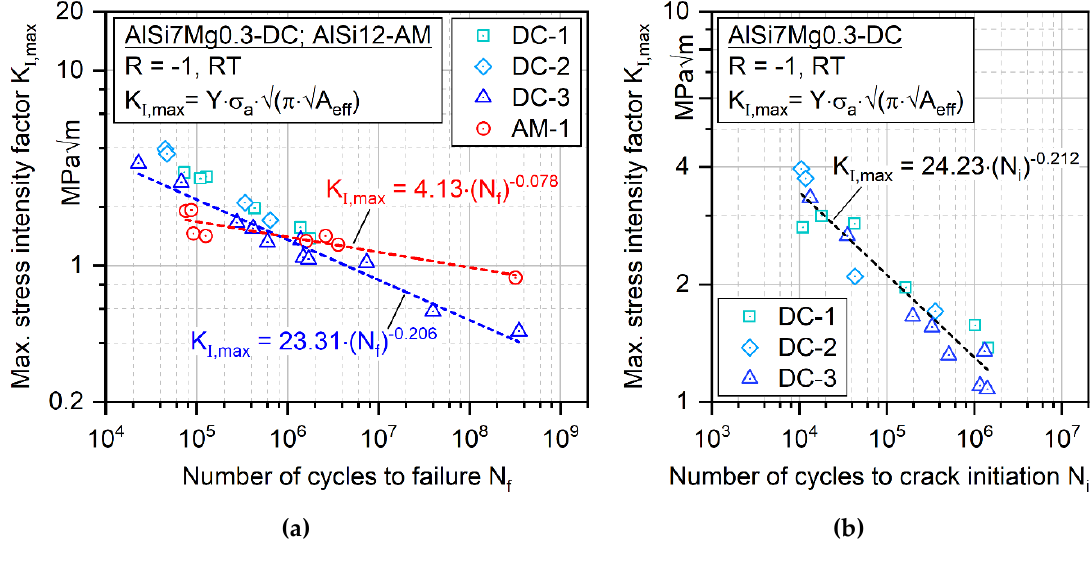
Figure 9. SIF–N curves for the ( a ) die-cast (DC) alloy AlSi7Mg0.3 and additively manufactured (AM-1) alloy AlSi12 from the LCF to VHCF regime and ( b ) die-cast (DC) alloys related to crack initiation lifetime from the LCF to HCF regime.